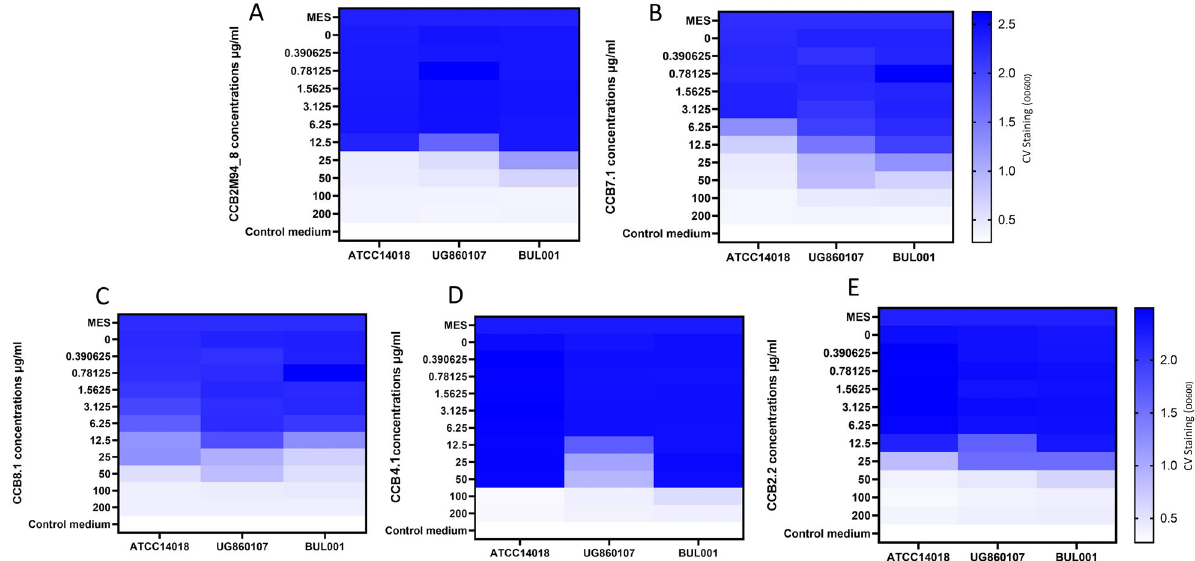
Fig. 2 Endolysin bio fi lm prevention activity: Bio fi lm prevention assay using G. vaginalis ATCC14018, G. vaginalis UG860107, and G. vaginalis BUL001 cultures. Final concentrations of A CCB2M94_8, B CCB7.1, C CCB8.1, D CCB4.1 or E CCB2.2, from 0.39 to 200 μ g/ml were used to prevent bio fi lms. OD 600 readings are the average of biological triplicates. Controls: MES corresponds to bacteria with MES buffer and control medium is the no bacterial